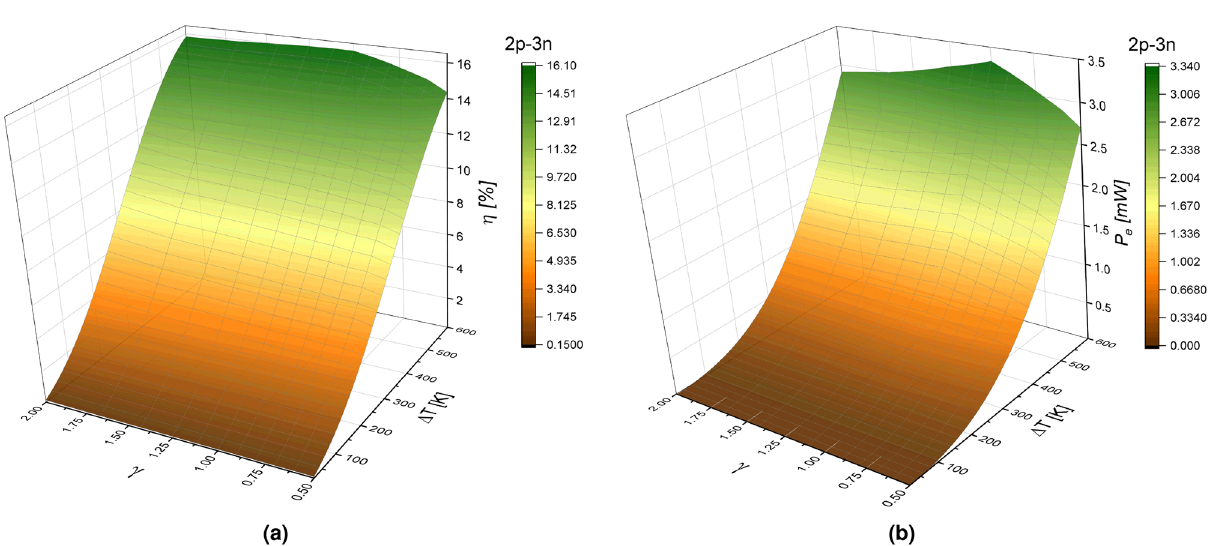
Figure 5. ( a ) Efficiency (η) and ( b ) Output power ( P e ) in function of geometric factor (γ) and temperature difference (� T ) for a TEG in the 2p-3n model at R L = 5.83 (cid:31)